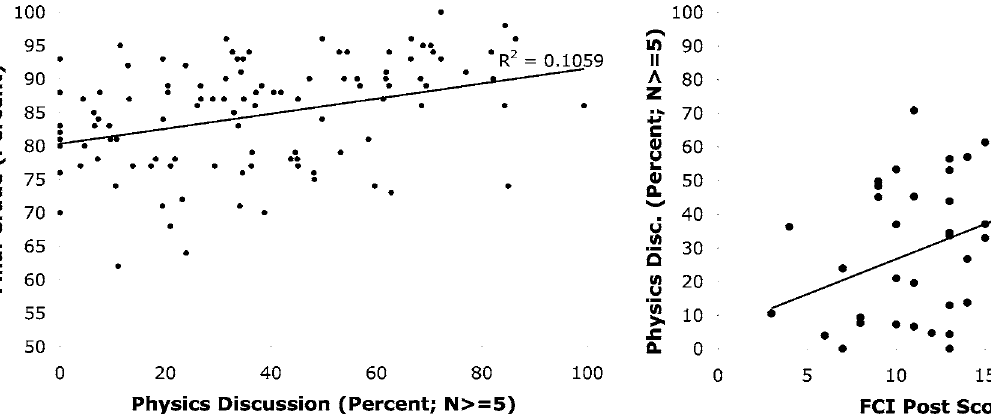
FIG. 2. Correlation of percentage physics-related discussions with grade percentage ( R =0.33 (cid:3) 0.15 → 0.49 (cid:4) (cid:1) n =111 (cid:2) ) .